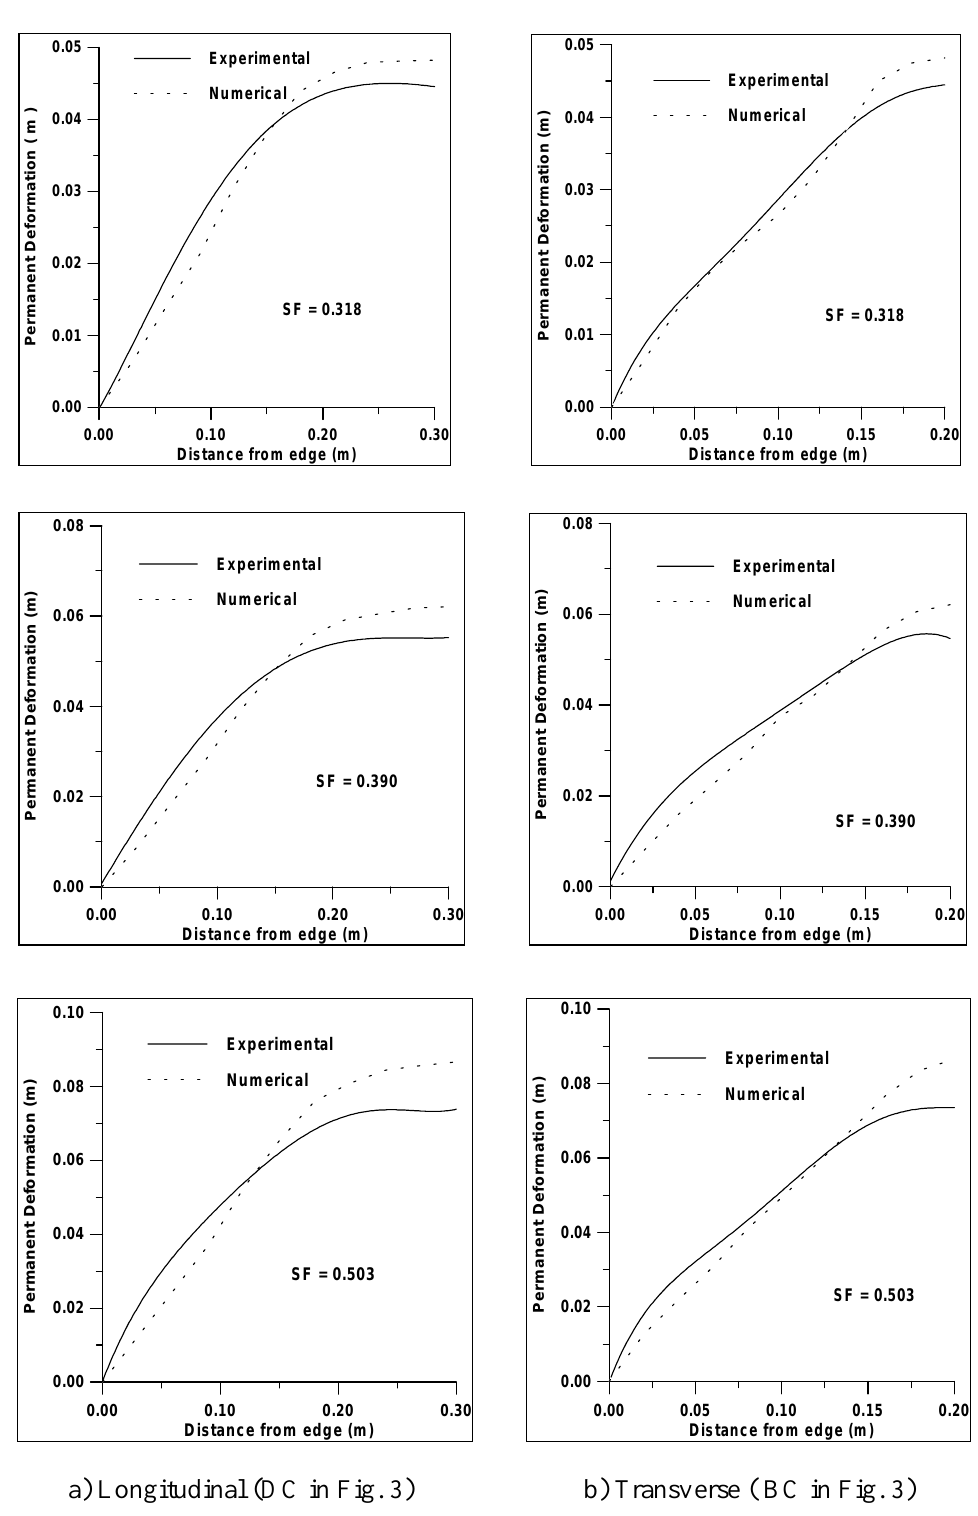
Fig. 14. Comparison of permanent deformation along center line ( h/l = 0 . 0